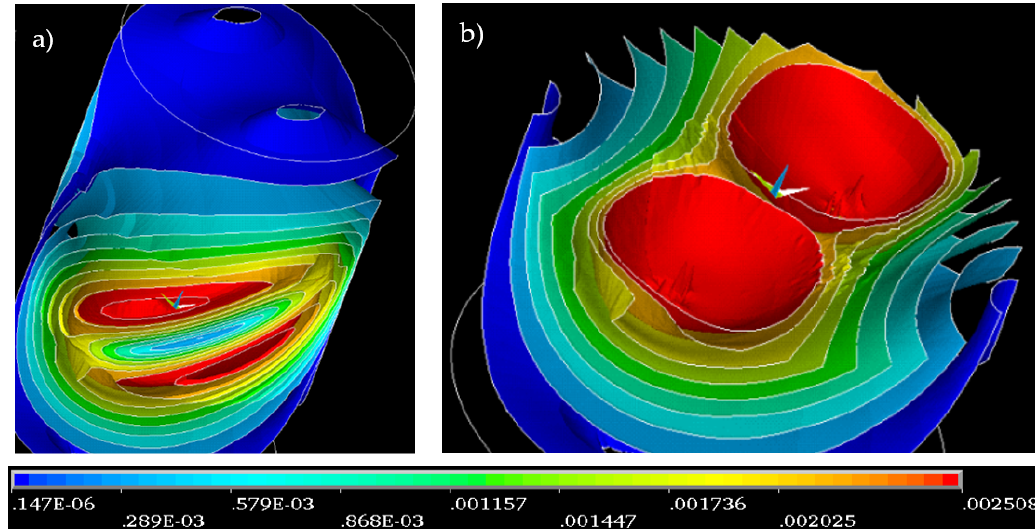
Figure 3. The magnetic field B [T] in the spiral arrangement of the permanent magnets. ( a ) In the vicinity of the cylinder surface; ( b ) in the remote region with respect to the magnets.